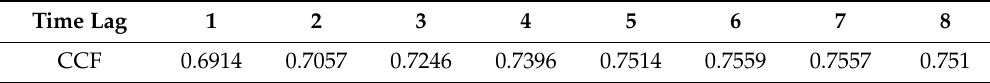
Figure 4. Plots of observed data and water level modeling using different neural network models.